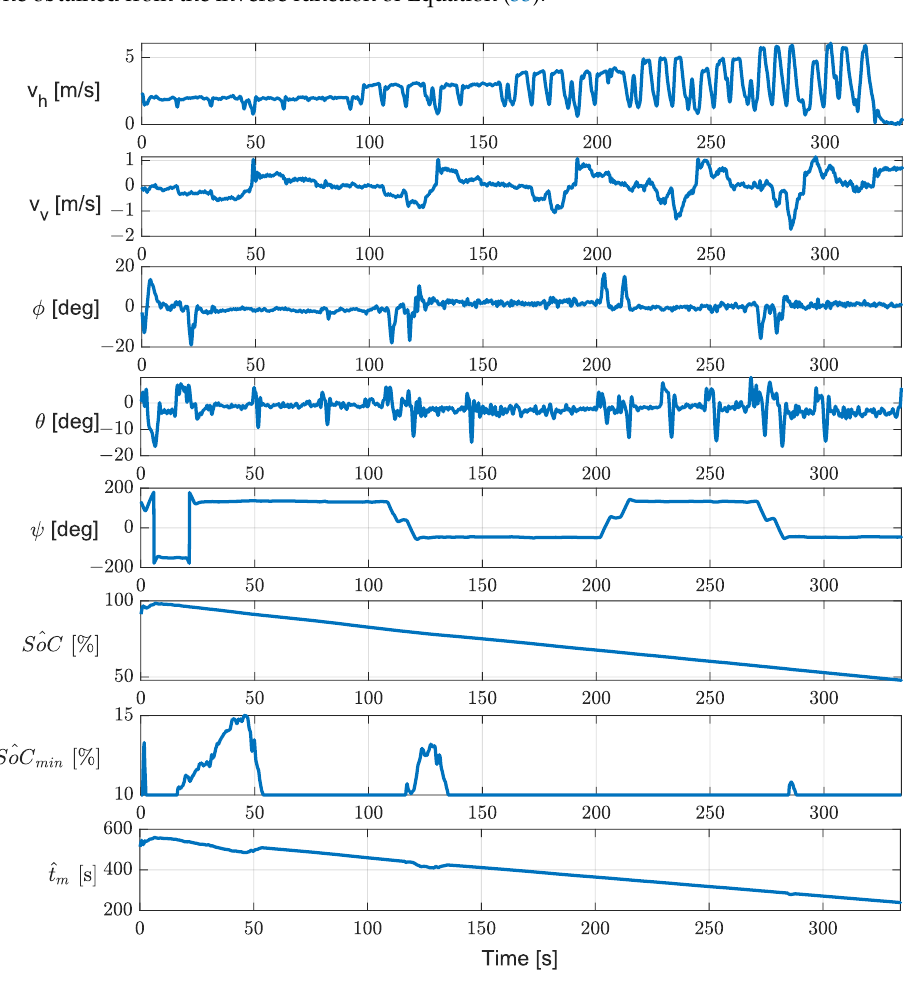
Figure 17. Parameters obtained from the validation flight. From top to bottom, horizontal velocity ( v v ), vertical velocity ( v h ); roll ( φ ), pitch ( θ ), yaw ( ψ ) angles; estimated state of charge, ˆ SoC ; minimum admissible state of charge, ˆ SoC min ; and flight time margin, ˆ t m